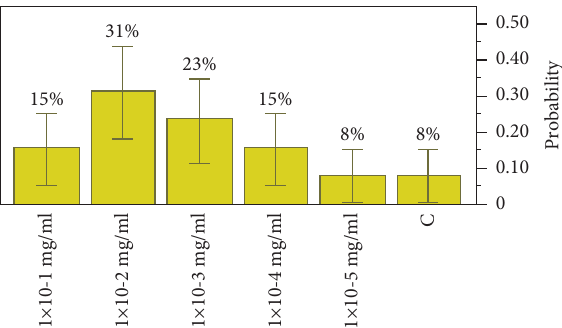
Figure 3: Distributions and test probabilities of extract C on target